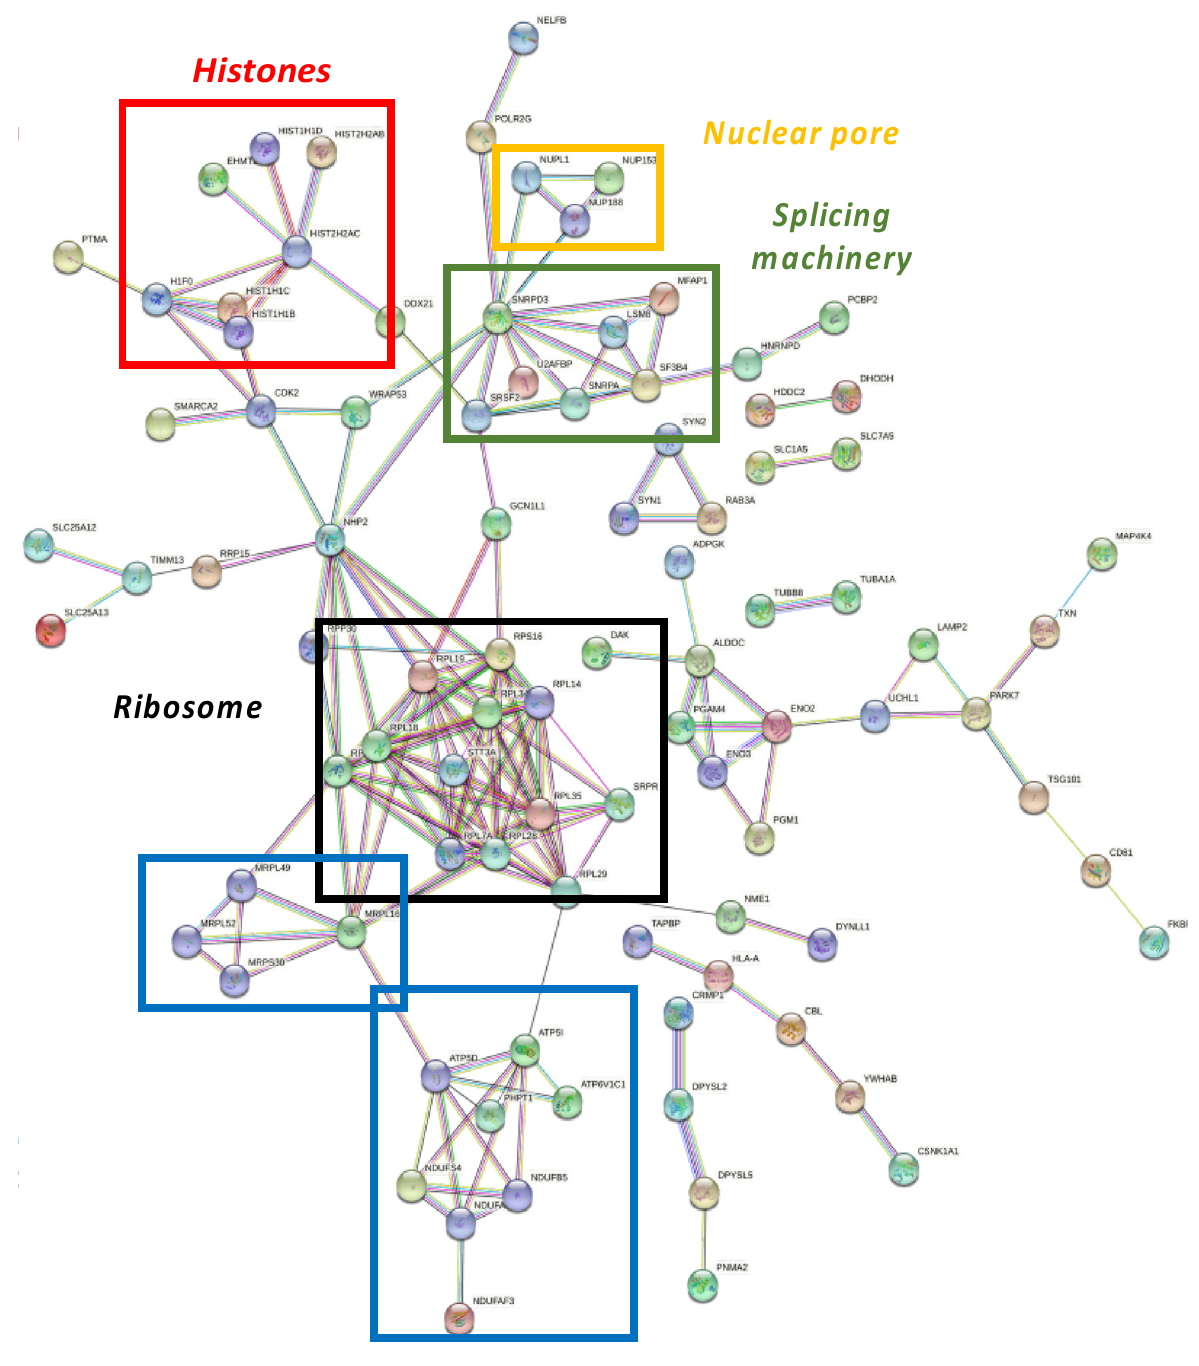
Figure 4. Functional interactome network for differentially expressed proteins in NOX5- β -infected hCMEC/D3. Proteins are presented as nodes and interactions between proteins as connection lines by the STRING ® software (v11.5, online). Some protein clusters represent cell structures, which are highlighted by colored squares. These data point out that NOX5- β overexpression alters histones (red), nuclear pores (yellow), splicing machinery (green), ribosomes (black), and the electron transport chain and ATP synthase (blue).